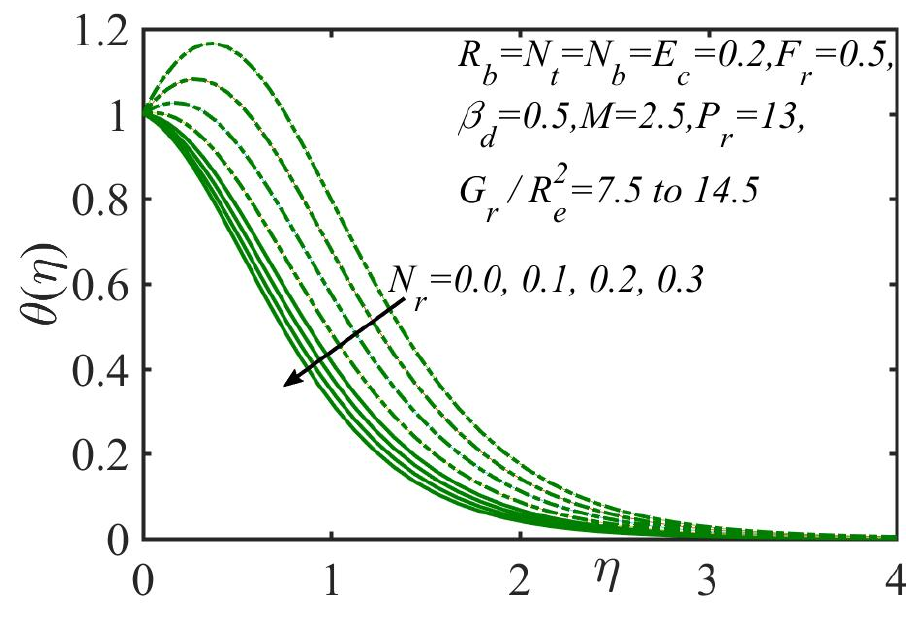
= 7.5 Dotted line: G r = 7.5 Dotted line: (cid:3008) (cid:3293) (cid:3019) (cid:3280)(cid:3118) R 2 e